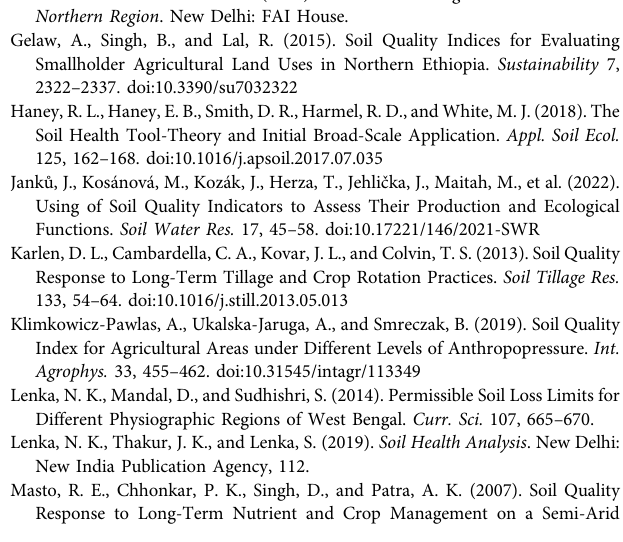
Supplementary Figure S3 | Correlation of soil quality index (SQI) derived from the soil data of 0 – 15 cm and 0 – 30 cm with wheat yield under the four different indexing methods ( n =